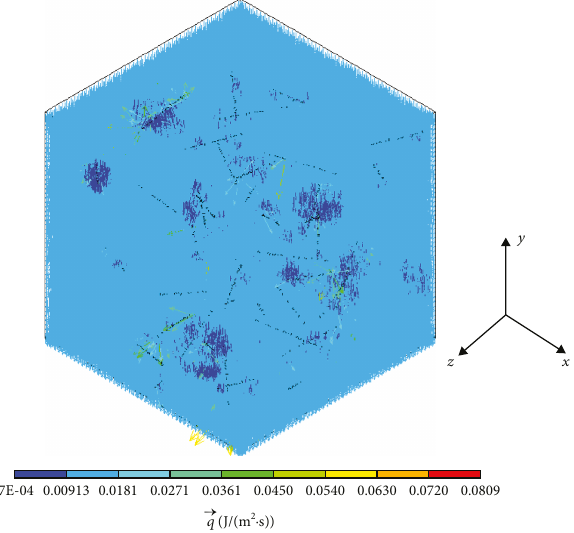
Figure 31: Heat fl ow vector of the fi ber scale model of the wrapper.